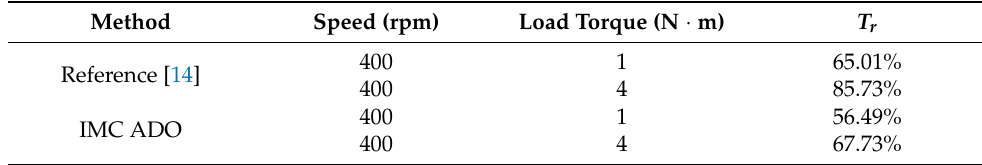
Table 3. The torque ripple percentages for both methods when the load torque changes.